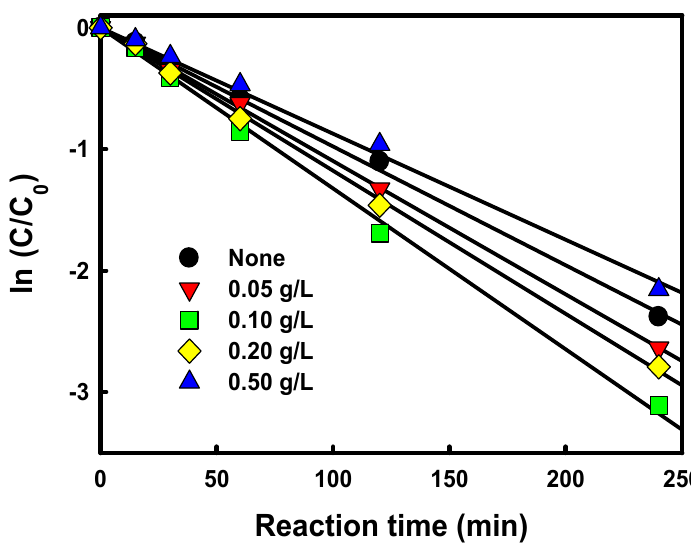
Figure 3. Degradation rate of ASA measured at various TiO 2 photocatalyst addition amounts.